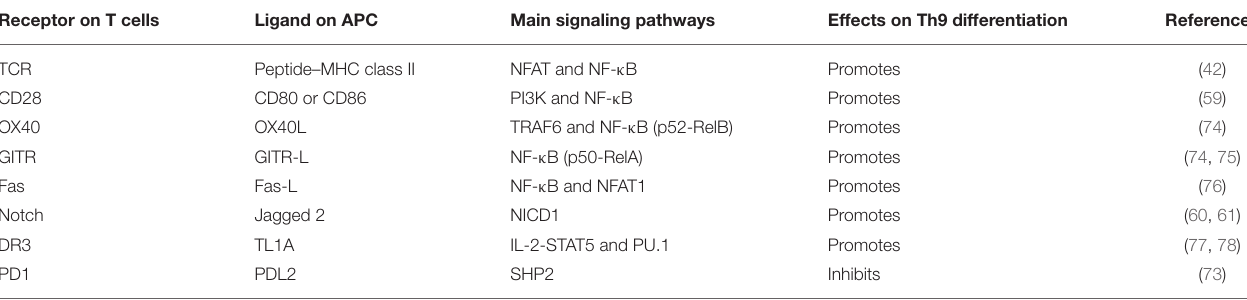
TABLE 1 | T cell receptor and co-stimulatory molecules and soluble factors that are involved in Th9 cell differentiation. Receptor on T